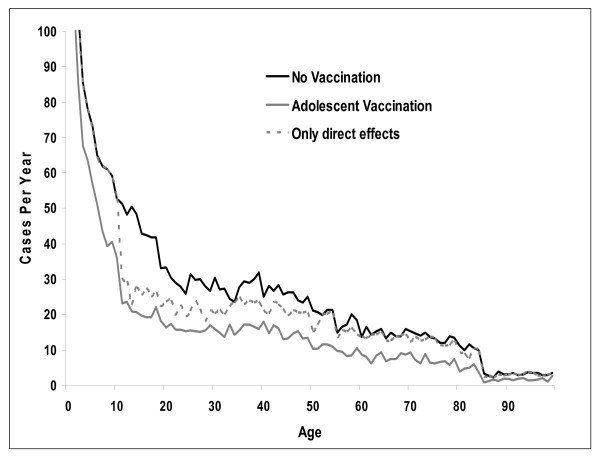
Estimated number of cases with and without routine vaccination of adolescents at steady state†. The dashed line ('Only direct effects') represents the estimated number of cases with vaccination, but assuming no herd immunity. † Steady state refers to years when all individuals in the simulation between the ages of 12 and 100 years have been eligible for vaccination under the routine program.